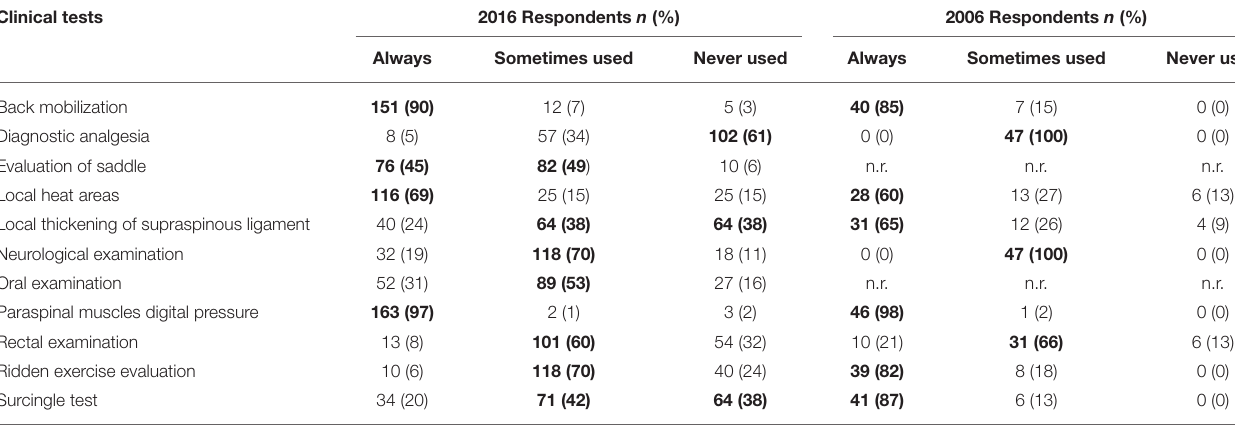
TABLE 2 | Clinical tests used by the 2006 and 2016 survey respondents in order to detect back-pain in horses. Clinical tests